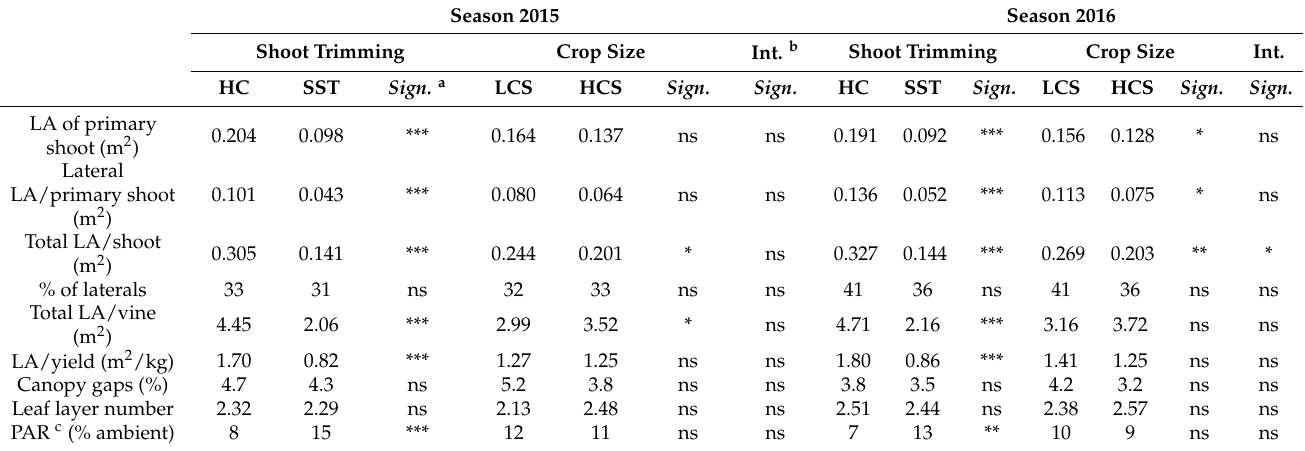
Table 4. Leaf area and fruit zone characteristics of Merlot grapevines subjected to two different trimming heights (HC, high canopy and SST, severe shoot trimming) and two different crop sizes (LCS, low crop size and HCS, high crop size).